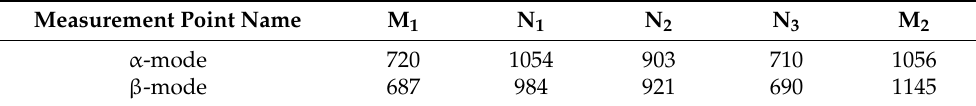
Table 5. Sampling numbers that the initial wave arrives at each measurement when the fault occurs on a T